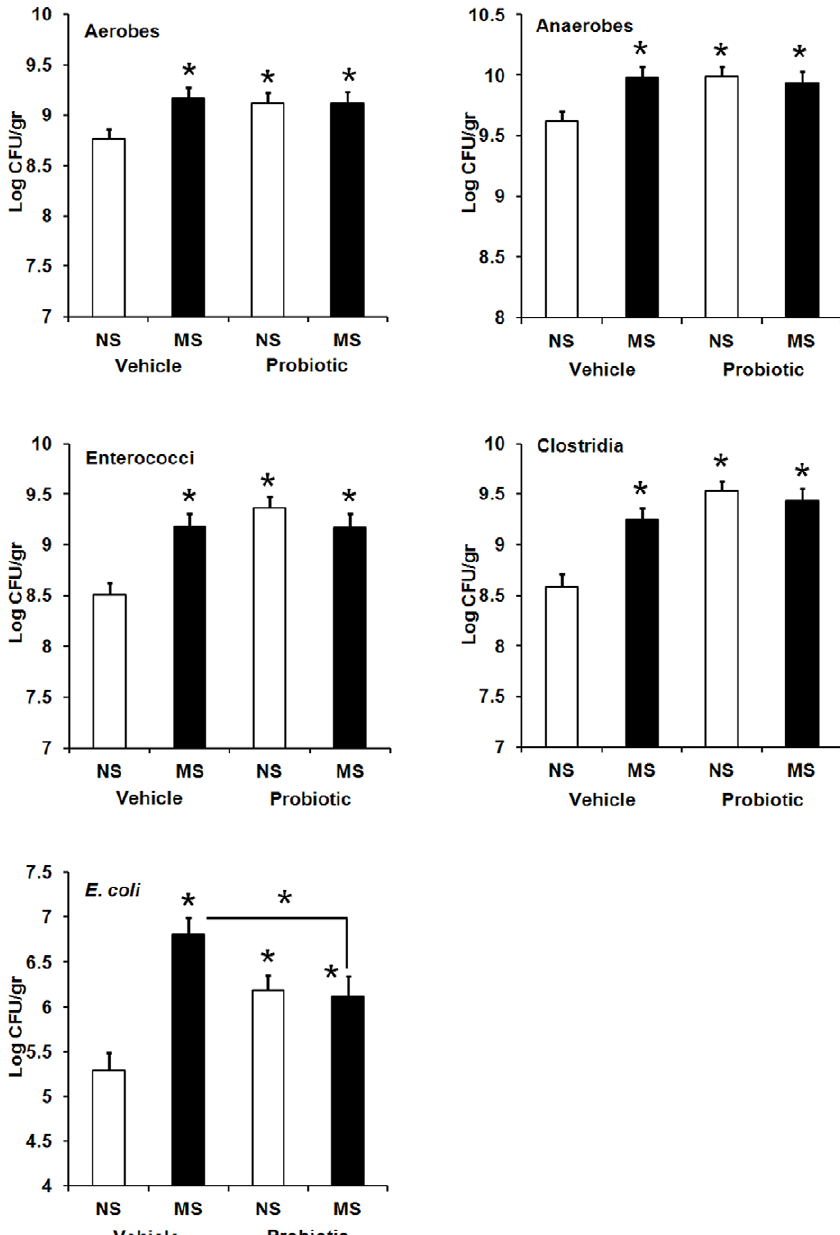
Figure 6. Effect of early life stress and maternal probiotic intake on neonatal gut microflora. Effect of neonatal maternal separation (MS) and maternal probiotic intake on composition of gut microflora (Log CFU/gr, least squares means + SE) in Wistar rats at PND 24. Hollow bars represent animals exposed to no neonatal stress (NS): NS vehicle (n=14–20), NS probiotic (n=19–20). Filled bars represent animals exposed to neonatal maternal separation (MS): MS vehicle (n=19–20), MS probiotic (n=20). An asterisk (*) shows significant difference compared to NS animals in the vehicle subset ( p # 0.05).